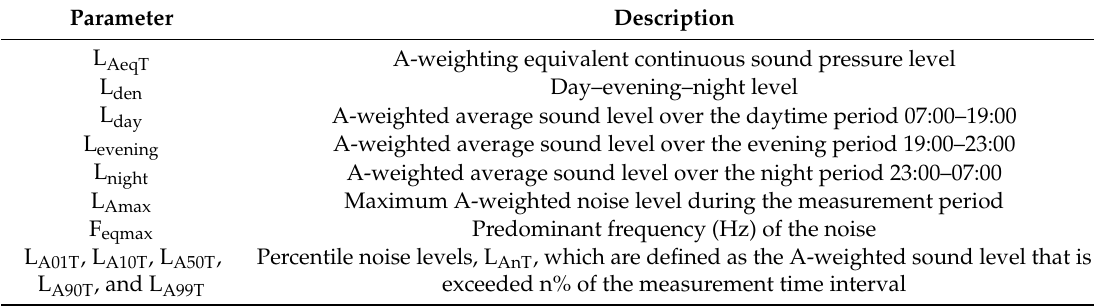
Table 1. Information provided by the system.